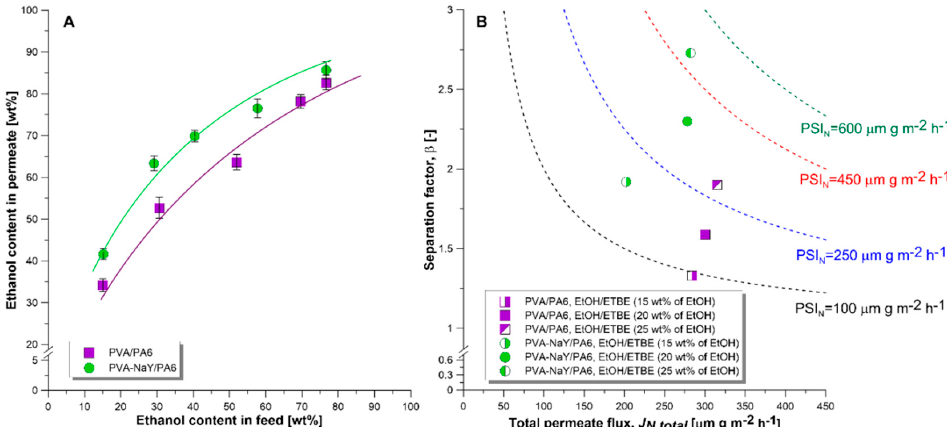
Figure 11. ( A ) McCabe–Thiele separation diagram for investigated membranes in contact with ETBE/EtOH mixture. ( B ) Comparison of membrane’s efficiency of PVA/PA6 and PVA-NaY/PA6 membranes in the removal of ethanol from ETBE/EtOH mixture containing 15, 20, and 25 wt % of EtOH. Dashed lines correspond to the following values of PSI N : black – PSI N = 100 µ m g m − 2 h − 1 , blue – PSI